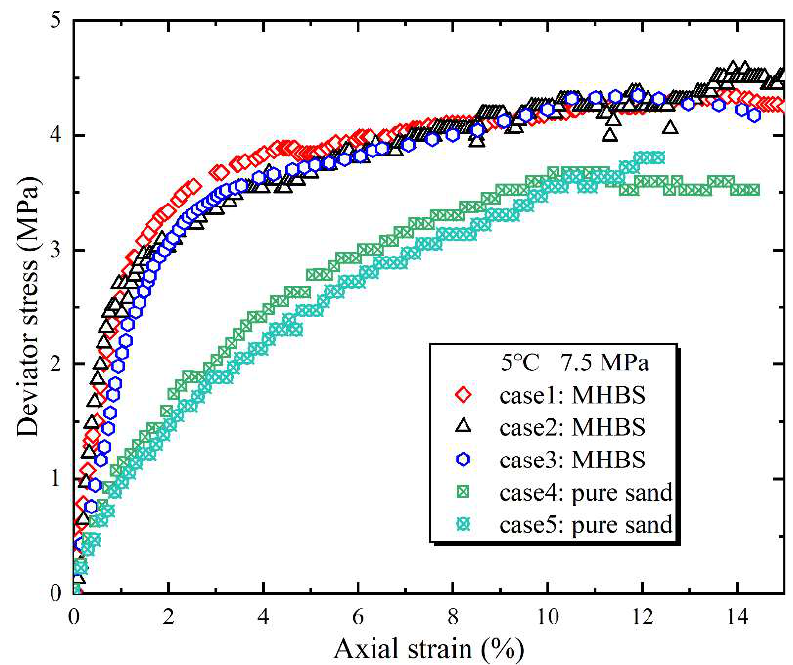
Figure 6. Experimental reproducibility verification: MHBS and pure sand.